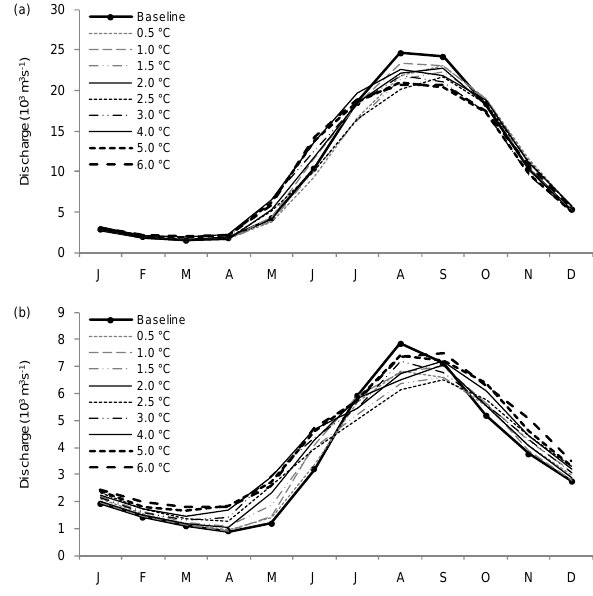
Fig. 3. HadCM3 climate change signal for 0.5–6 ◦ C increases in global mean temperature: (a) mean monthly discharge of the Mekong at Pakse (Mekong 2), (b) mean monthly discharge of the Lancang sub-basin at